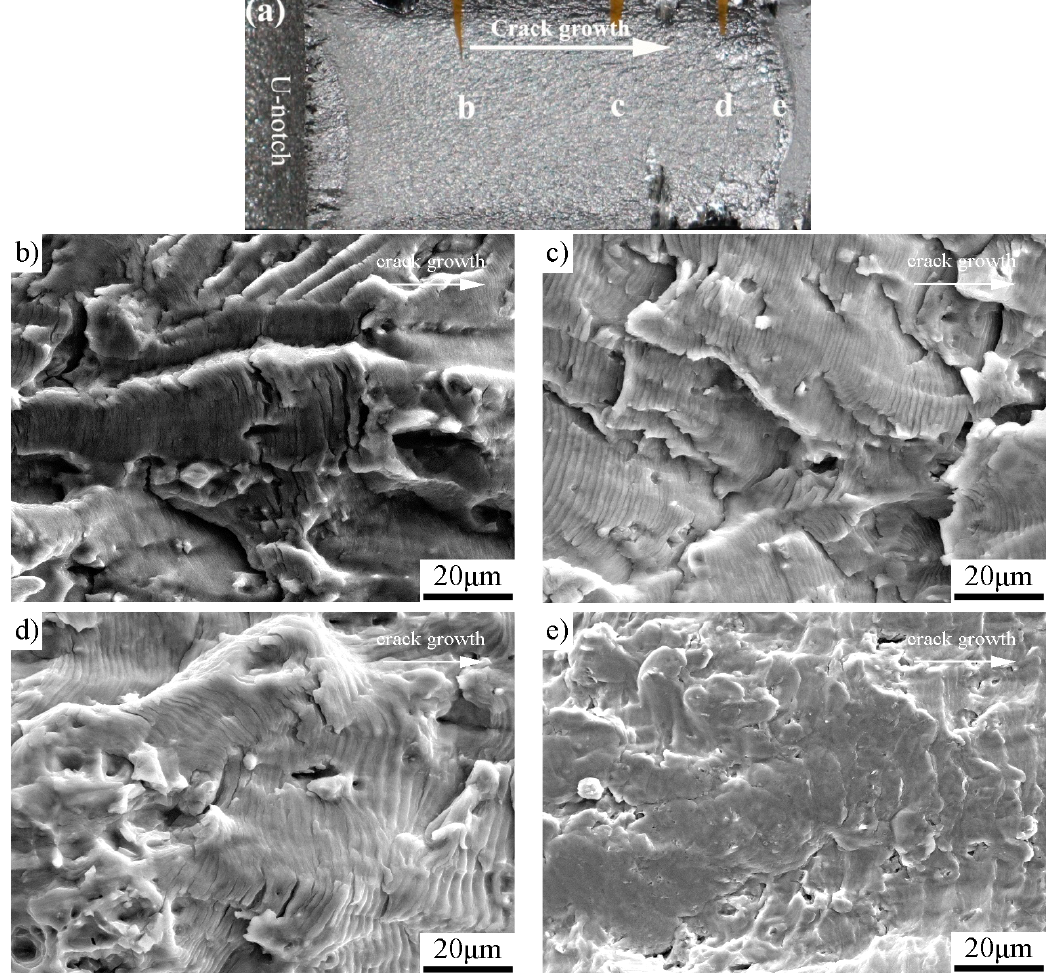
Figure 5. The as-received specimen: ( a ) macrograph showing the detailed SEM locations; ( b ) Δ K app ≈ 20 MPa √m ; ( c ) Δ K app ≈ 30 MPa √m (striation spacing ≈ 1.7 μ m); ( d ) Δ K app ≈ 40 MPa √m (striation spacing ≈ 3.2 μ m); and ( e ) unstable propagation zone.